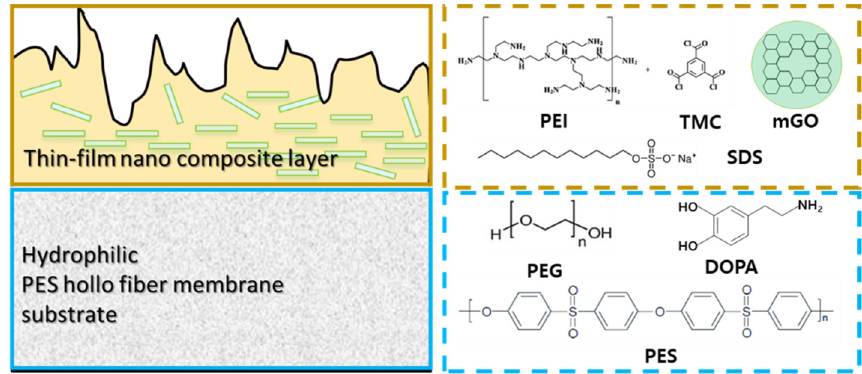
Figure 1. Schematic diagram of an mGO-thin-film composite hollow fiber